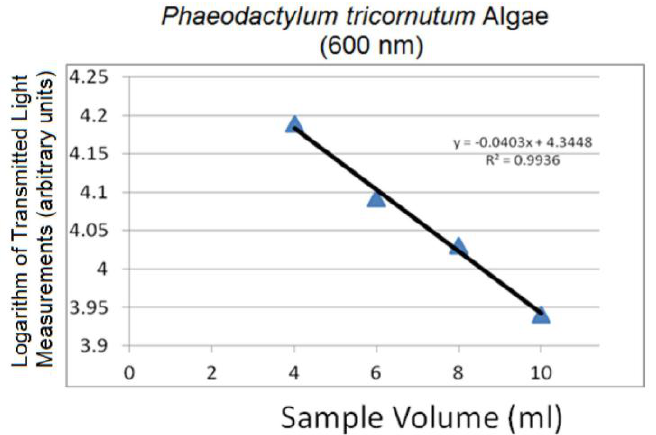
Figure 13. Logarithm of 600 nm spectral peak ( Phaeodactylum tricornutum